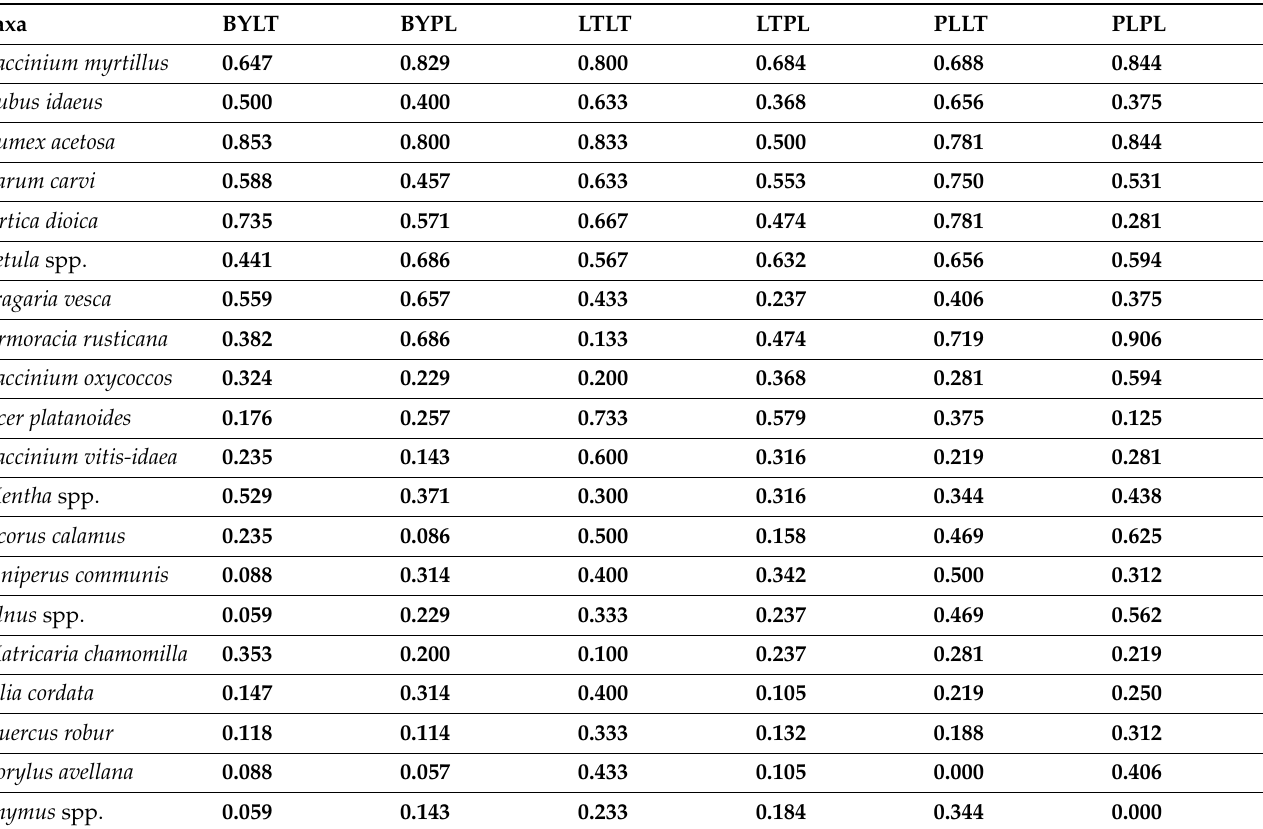
Table 4. The relative frequency of citation of the top 20 wild plants mentioned by interviewees in the study